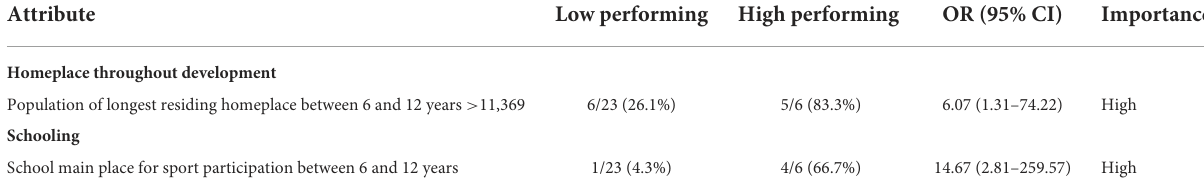
TABLE 4 Logical attributes for all discriminative features within demographics and familial sport